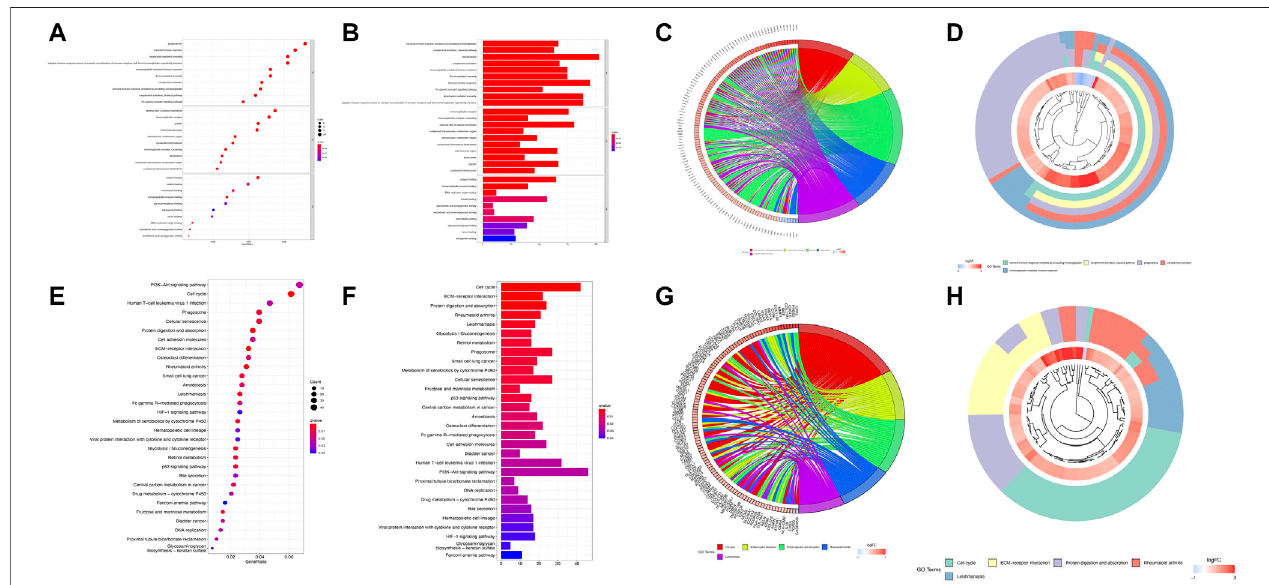
FIGURE5| FunctionalanalysisbasedontheDEGsbetweenthehigh-andlow-riskgroups.Thebubbleplot (A) ,barplot (B) ,circularplot (C) ,andclusterplot (D) of the GOpathways enriched for thepyroptosis-related DEGs between thehigh- and low-risk groups. Thebubble plot (E) , barplot (F) ,circular plot (G) ,and cluster plot (H) of KEGG pathways enriched for the pyroptosis-related DEGs between the high- and low-risk groups.